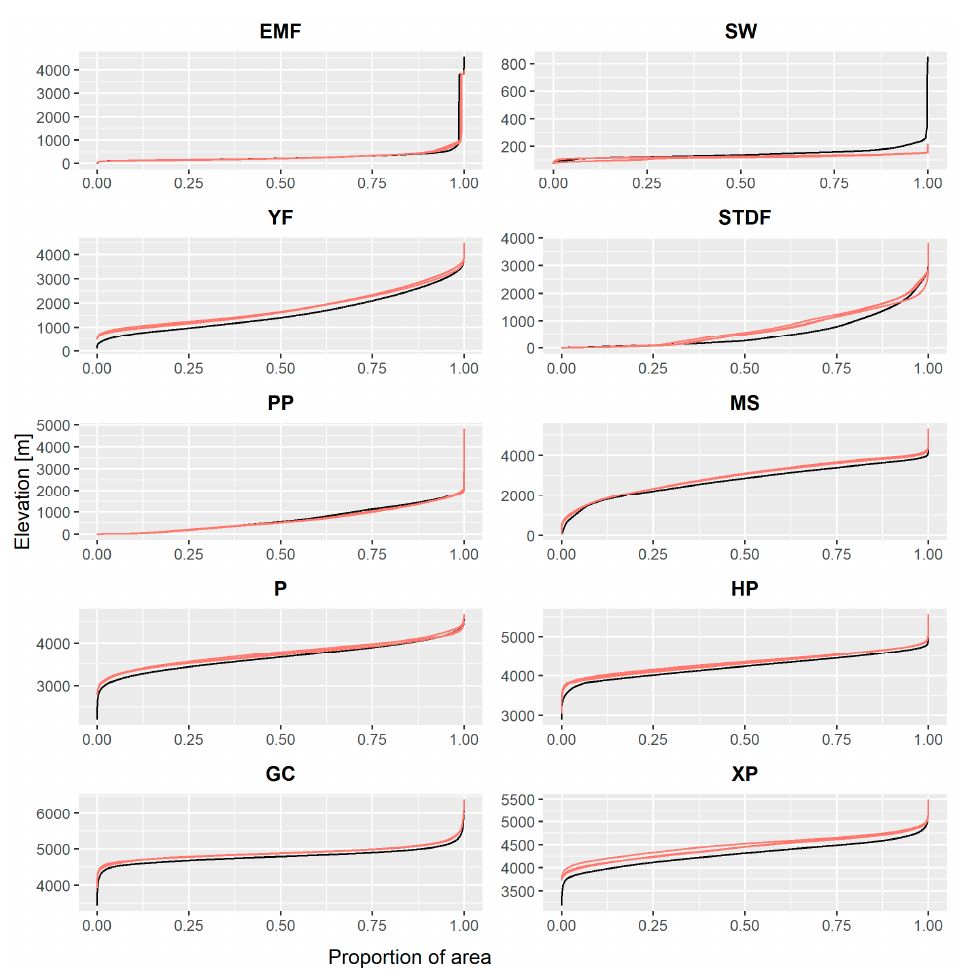
Figure 4. Hypsometric curves of the modeled biomes for their present (black line) and future configurations (red lines).